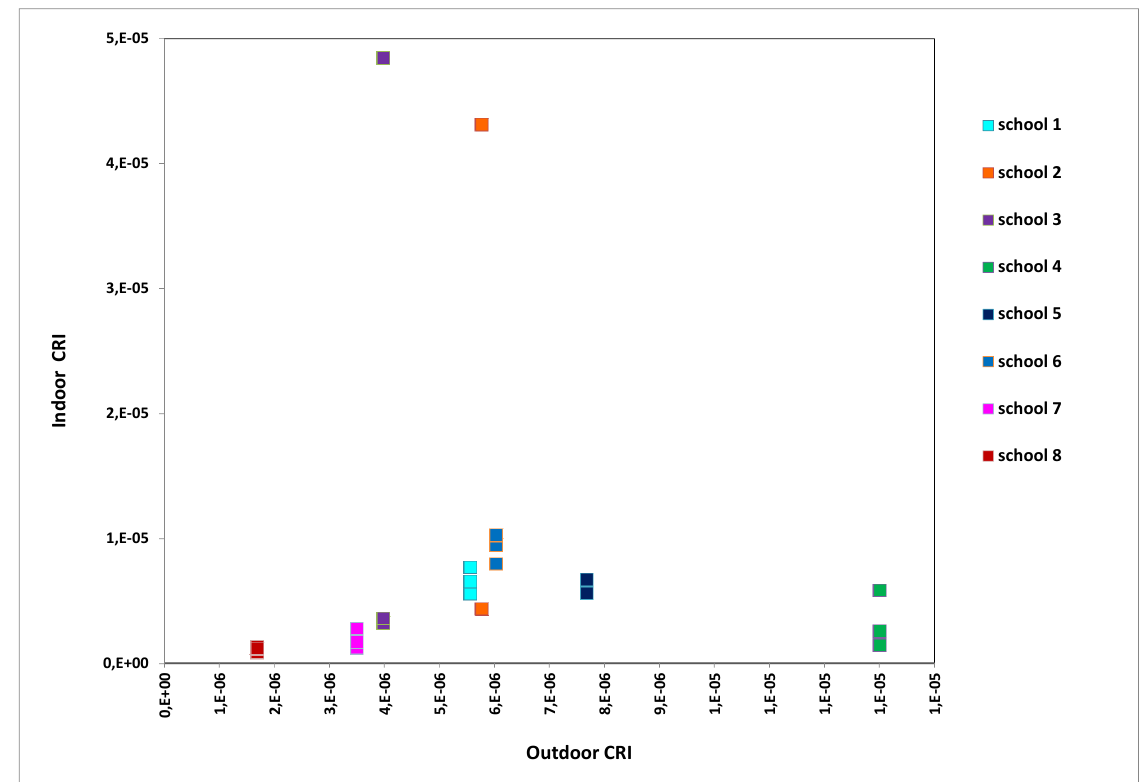
Figure 5. Indoor CRI against outdoor CRI for each monitored